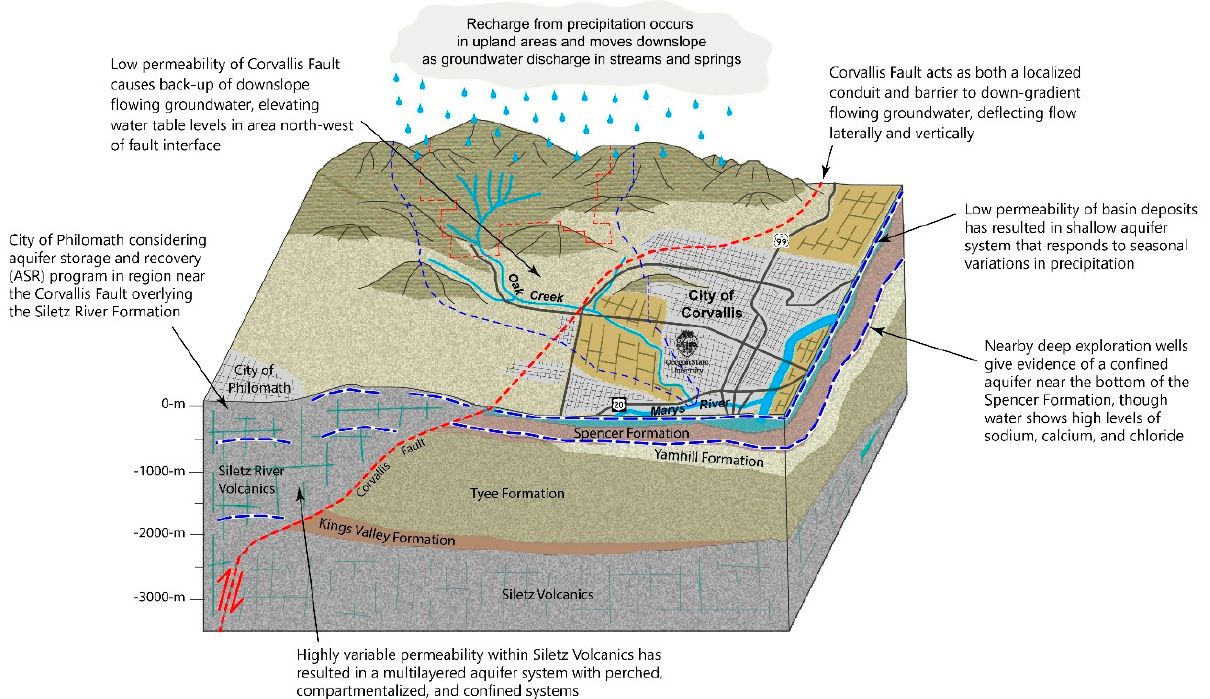
Figure 7. Conceptual model of the groundwater system of the Oak Creek Watershed and surrounding region based on a synthesis of topographic features and data from hydrologic and geologic investigations.